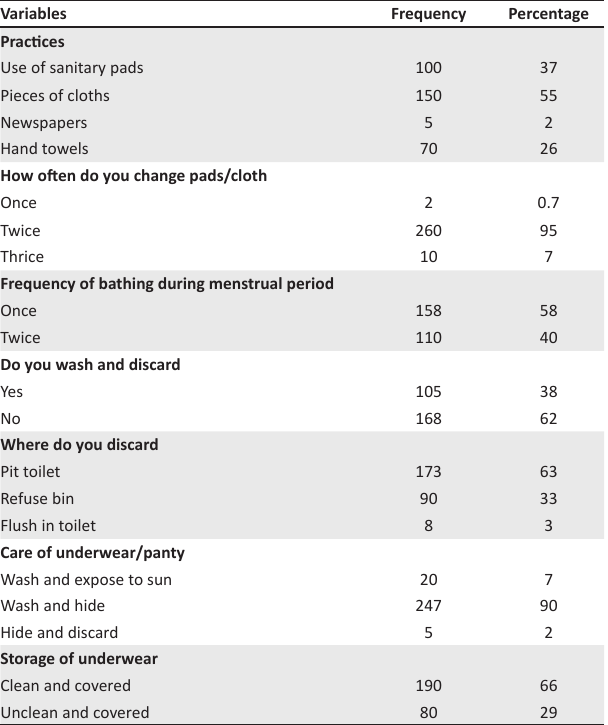
TABLE 2: Menstrual practices.